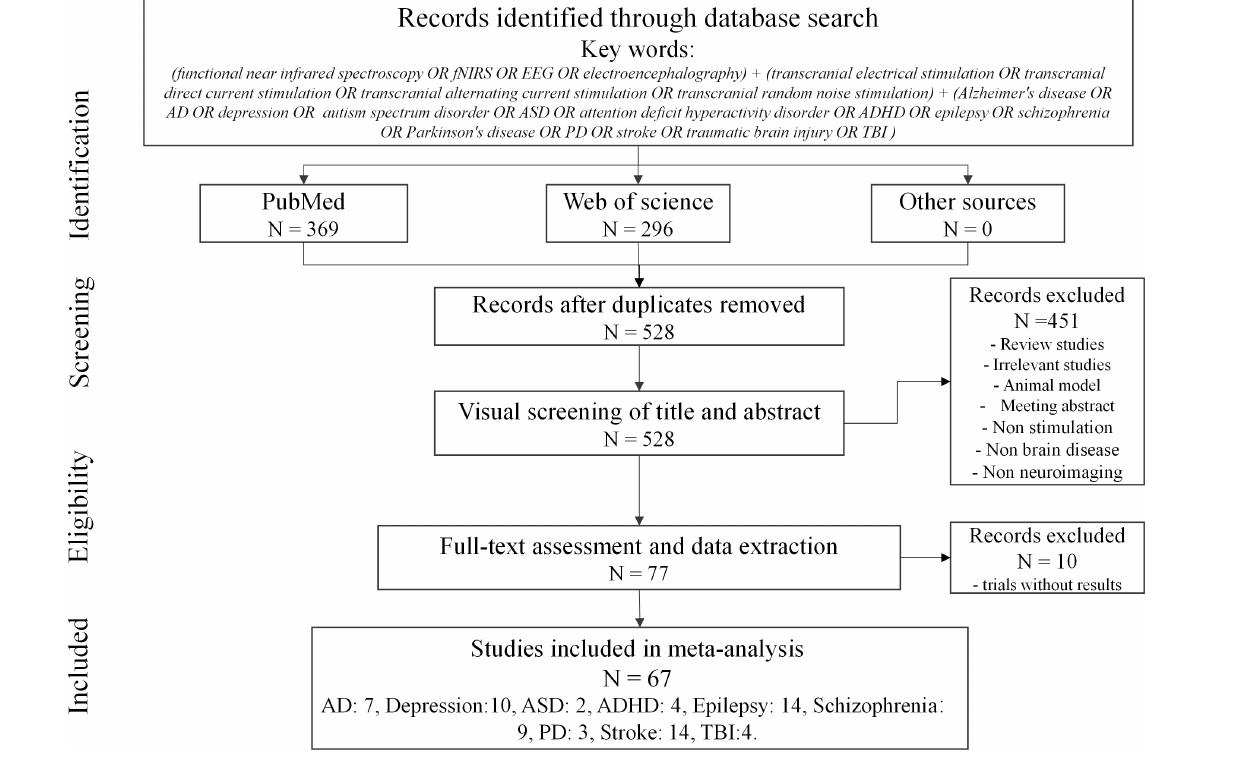
FIGURE 3 | Overview of literature search for